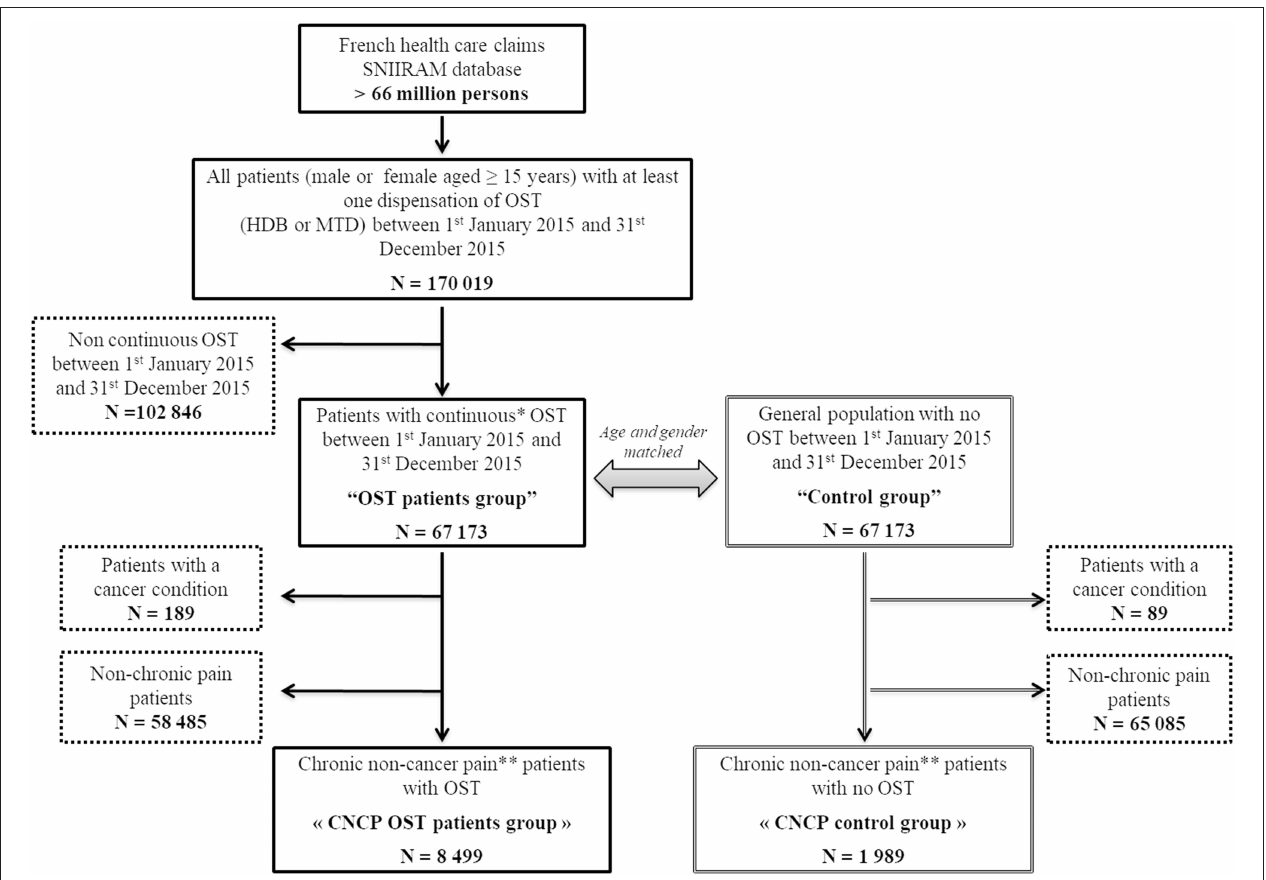
FIGURE 1 | Flow chart. OST, opioid substitution treatment; HDB, buprenorphine; MTD, methadone; CNCP, chronic non-cancer pain; SNIIRAM, Systeme National d’Infonnations Inter-Regimes de I’Assurance Maladie. *Interval between two consecutive dispensations ≤ 35 days for HDB and MTD capsule and ≤ l8 days for MTD syrup. **Patients treated continuously for at least 3 months with opioid analgesics and non-opioid analgesics (interval between two consecutive analgesic dispensations ≤ 45